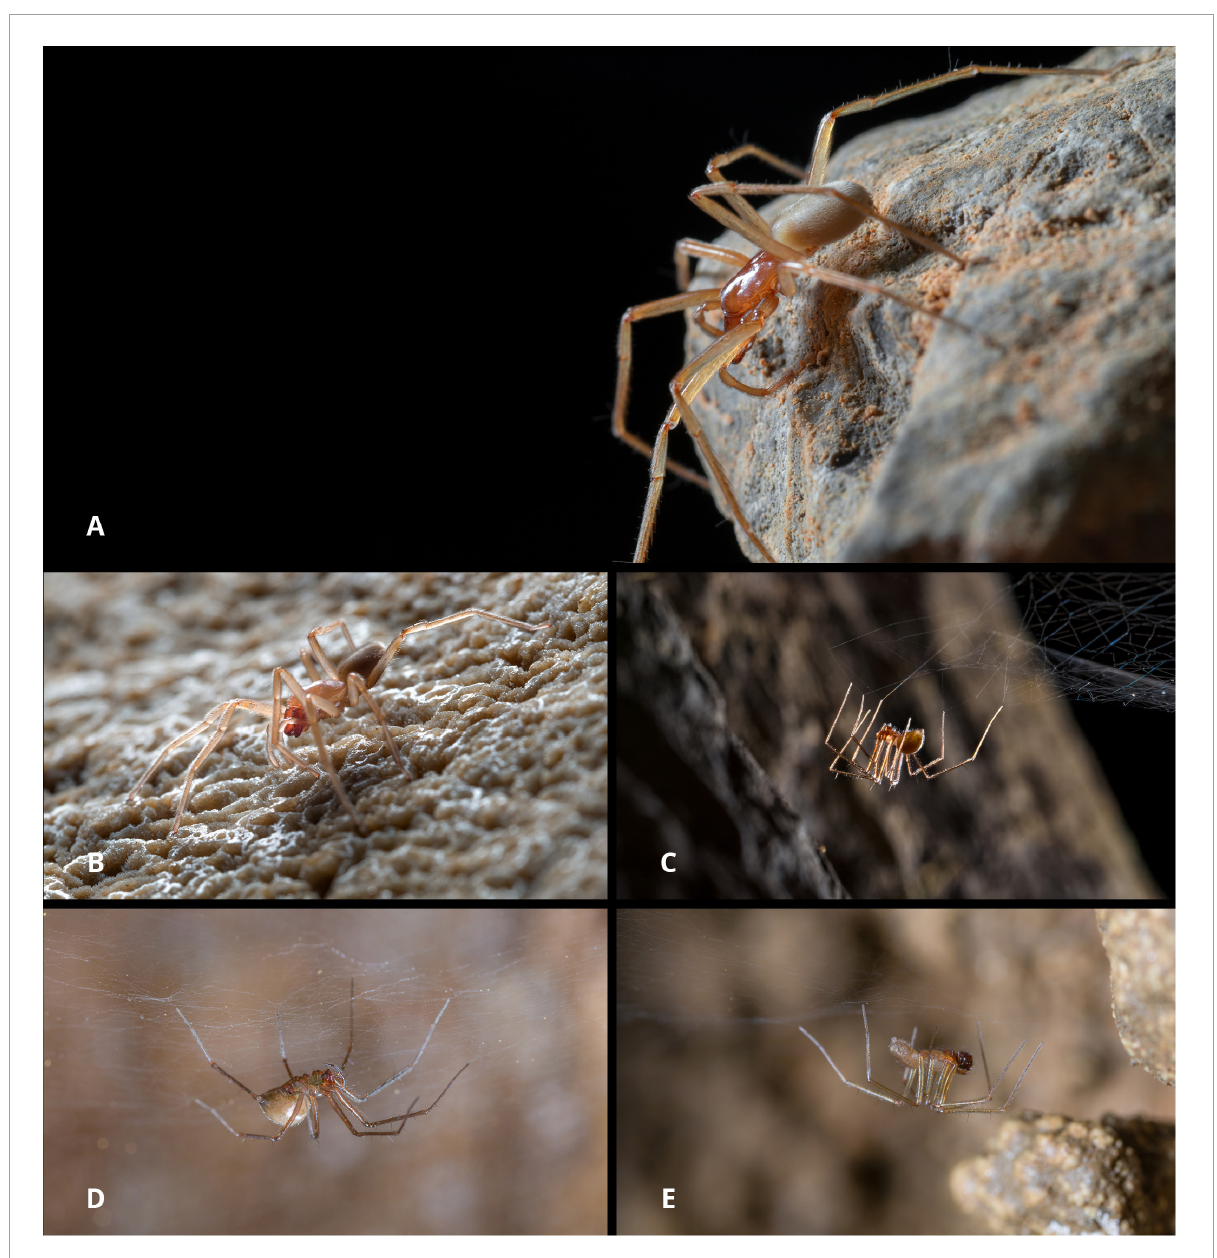
FIGURE1 Photographs of the five studied species. (A) Parastalita stygia , (B) Stalita pretneri , (C) Troglohyphantes croaticus , (D) Troglohyphantes excavatus , (E) Troglohyphantes kordunlikanus . Photos by: (A,B) Tin Rožman; (C) Jana Bedek; (D,E)